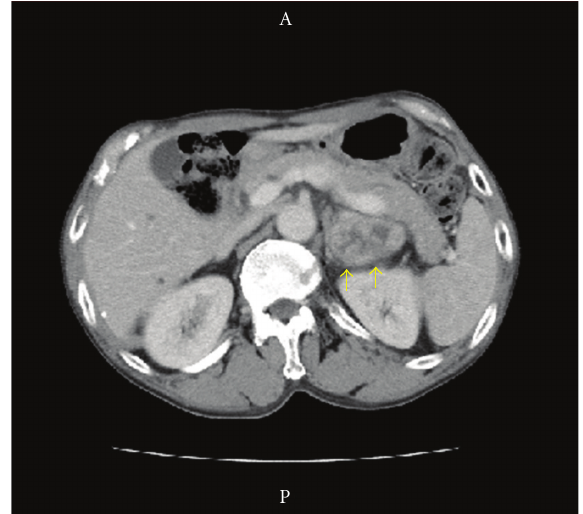
Figure 1: Computed tomography at 8 months after cystectomy shows a left adrenal tumor (5.0 × 4.0cm).